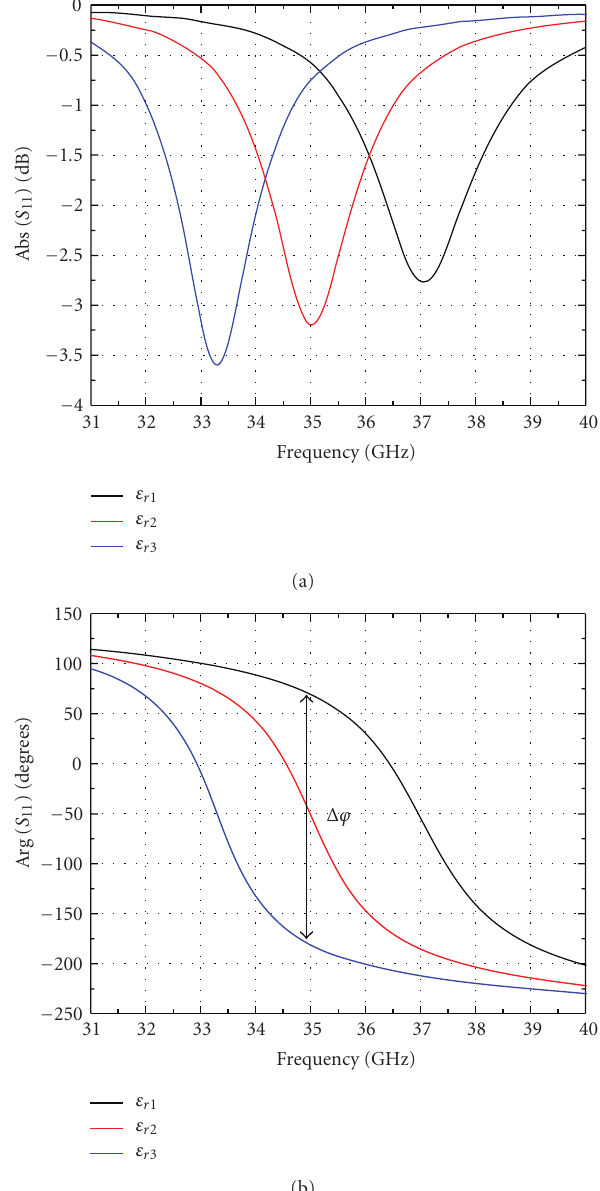
Figure 12: Functioning principle of a LC-tunable unit cell.